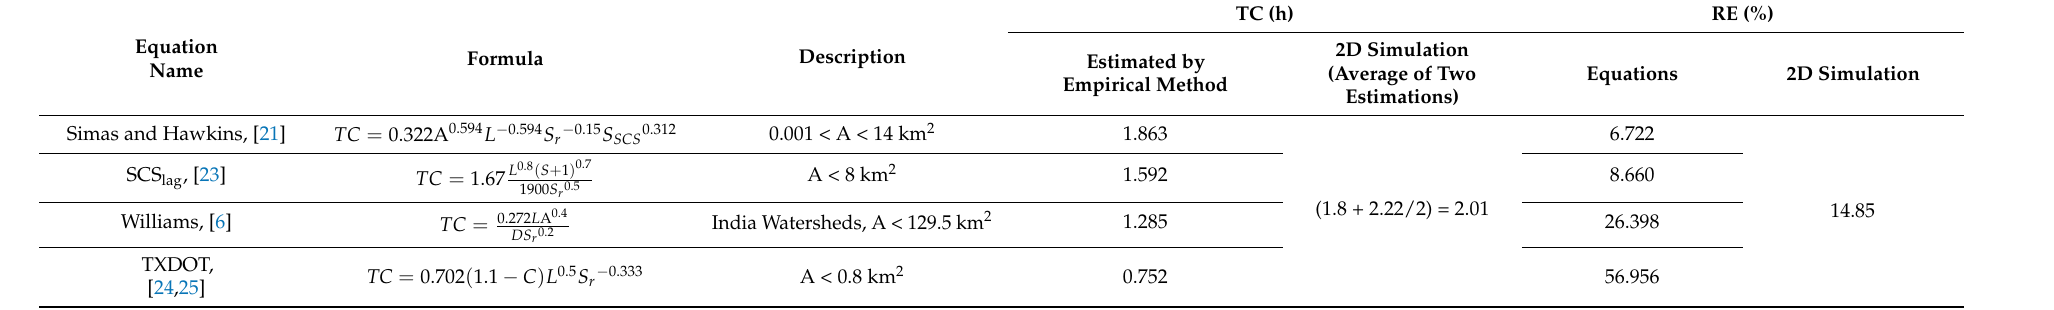
Table 3. TC (h) and RE (%) for methods based on S r , C , CN and D (category II).